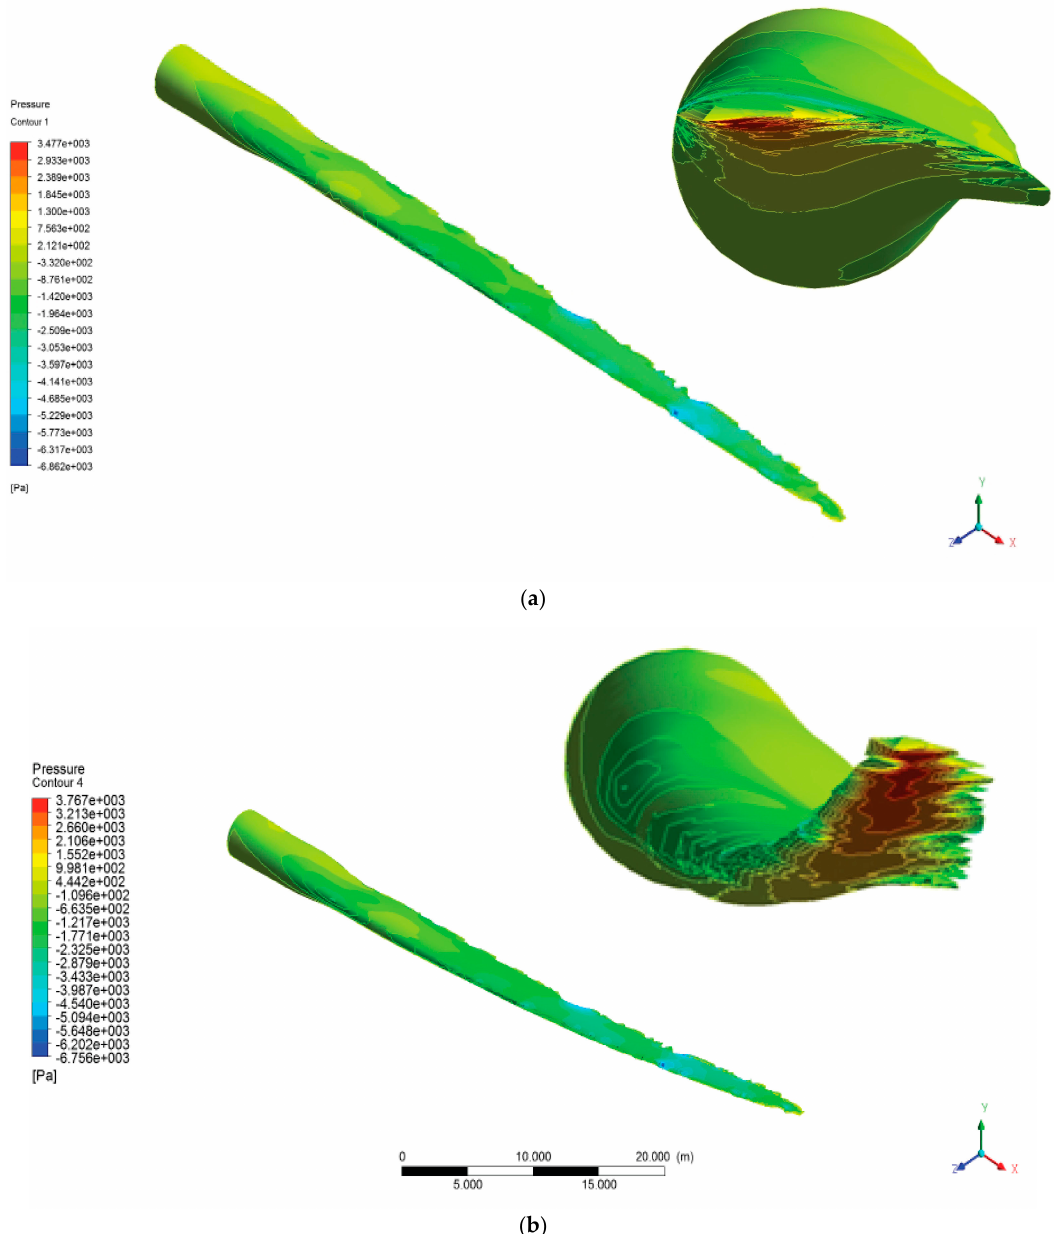
Figure 11. Pressure contour ( a ) uni-directional and ( b ) bi-directional at the 5 th second of the